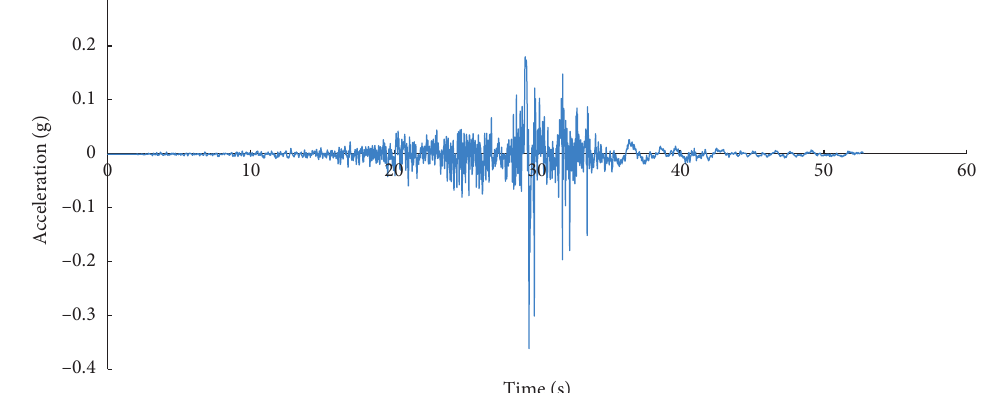
Figure 1: Acceleration time history of the Chi-Chi earthquake [21].